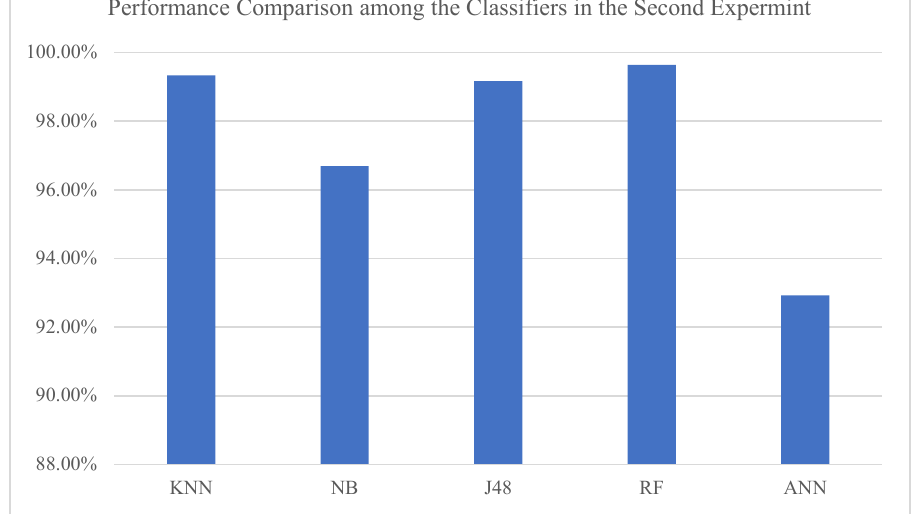
Figure 4. Comparison between results achieved in the first and the second experiment by each of the classifiers. ( a ): Performance analysis of the KNN classifier ( b ): Performance analysis of the NB classifier ( c ): Performance analysis of the J48 classifier ( d ): Performance analysis of the ANN classi- fier ( e ): Performance analysis of the RF classifier.